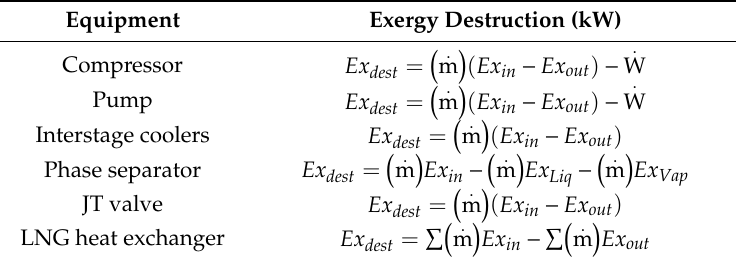
Table 5. Expressions for exergy destruction calculations in di ff erent equipment associated with the MFC–LNG processes [21].